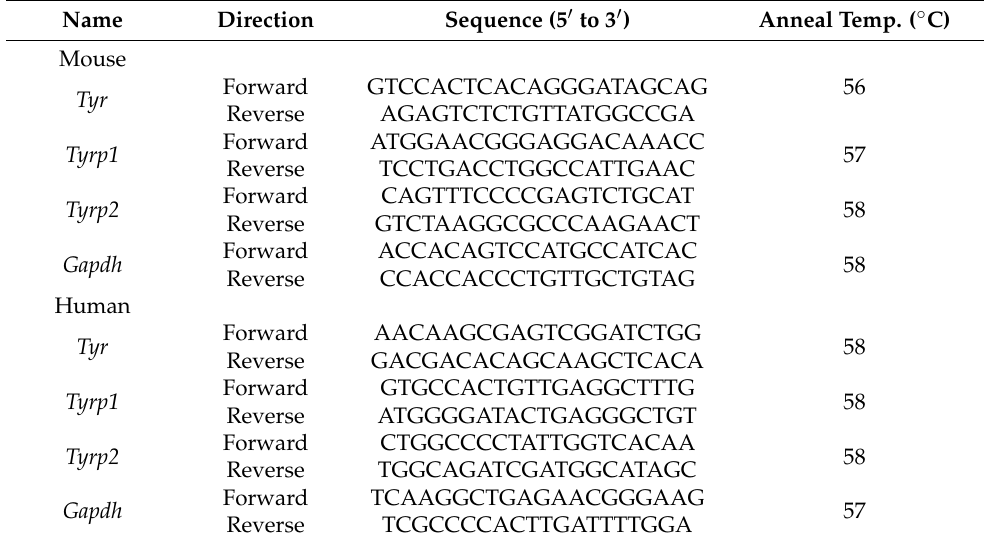
Table 1. Sequences of primers (mouse) used in